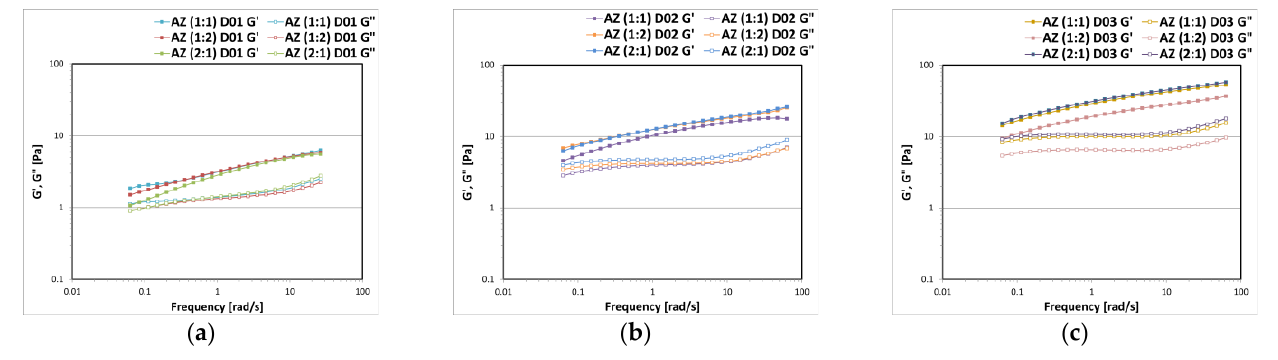
Figure 9. Storage G’ and loss G’’ moduli trend as a function of the oscillation frequency measured for the emulsions prepared with 10% w/w of oily phase O, A-Z associations at different ratios (1:1 – 1:2 – 2:1) at the same total solid phase amount (10% w/w) and D at 0.1% w/w ( a ), 0.2% w/w ( b ), and 0.3% w/w ( c ).